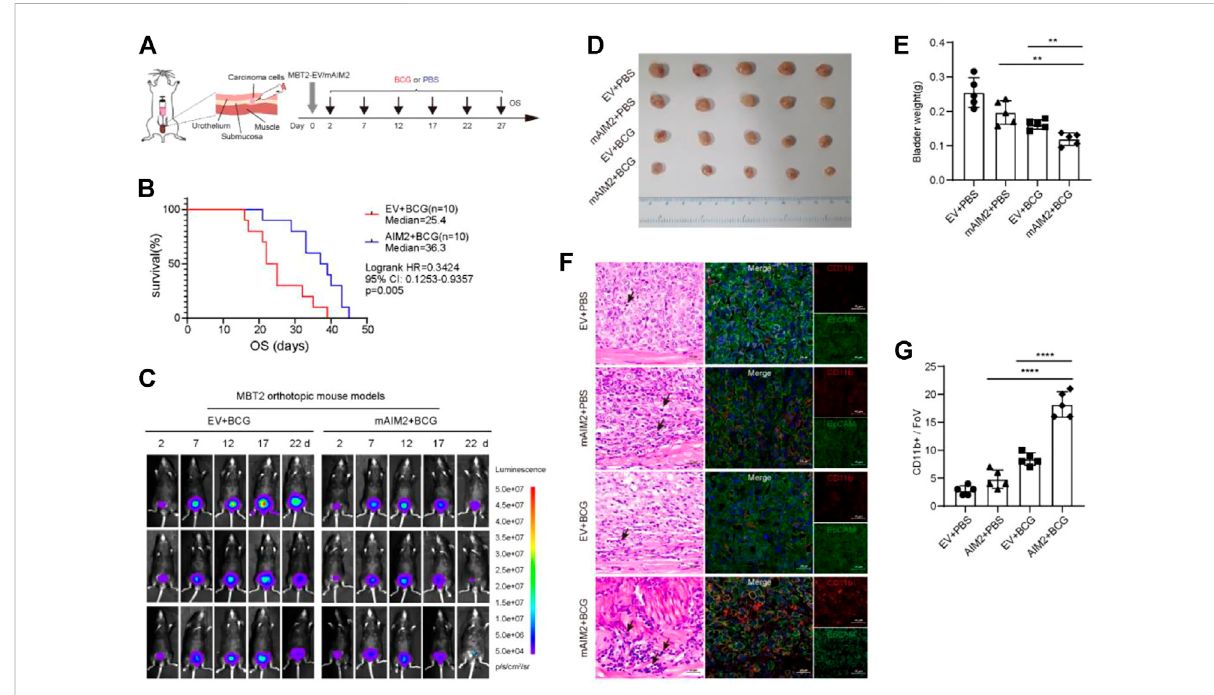
FIGURE 5 Tumorsgenerated bymAIM2-overexpressed MBT-2cells weremore sensitive toBCG immunotherapy. (A) Experimentalschematic. Mice were transplanted with 1.5 × 10 4 mAIM2-overexpressed MBT-2 cells or the control cells on day 0 and receive intravesical BCG or PBS on days 2, 7, 12, 17, 22, and 27. (B) Survival curves of mice from the indicated groups. (C) In vivo bioluminescence images to track the growth of mAIM2-overexpressed MBT-2cellsandthecontrolcellsafterintravesicalBCGinstillationoftheirbladdersondays2,7,12,17,22,and27. (D) Imagesoftumorsfromthe indicatedgroups. (E) Bladderweightoforthotopictumorsfromtheindicatedgroups. (F) RepresentativeimagesforHandEstainingofmicebladders after BCG therapy and confocal micrographs showing CD11b + cells in fi ltration. Black arrows indicate in fl ammatory cells. (G) Quanti fi cation of CD11b + cellsin fi ltration( n =5Fovs(40×);Fov, fi eldofview).Datain (E,G) arepresentedasthemeans±SD. p -valuesin (E,G) werecalculatedusingthe student ’ s t -test. Survival rate (B) is compared by Log-Rank (Mantel-Cox) test. *indicates p < 0.05, **, p < 0.01, ***, p < 0.001,****, p < 0.0001;ns, not signi fi cant ( p >